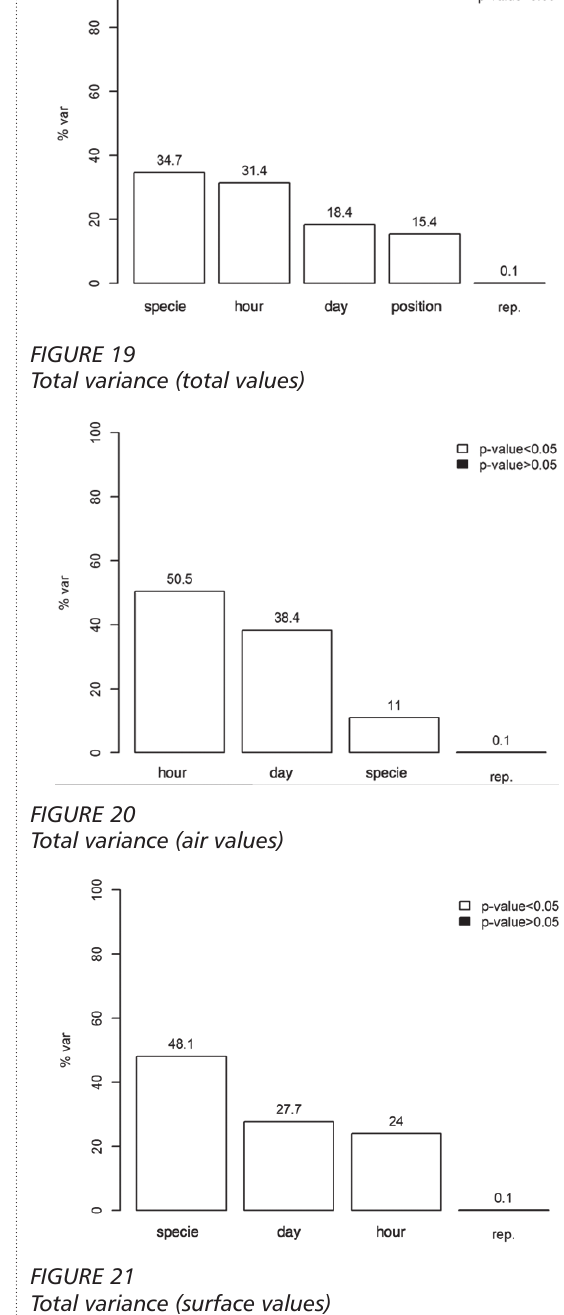
other trees studied, including Malay almond 2. No significant differences between air temperatures under the shadow of Malay almond 2 tree and air temperature related to the other trees were detected (with exception of Malay almond 1) and Honey berry